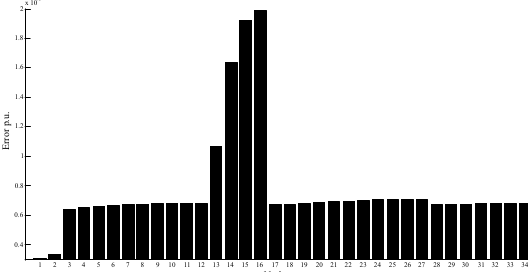
Fig. 2. Voltages error in p.u. for DS34N test system between backward-forward sweep algorithm and EVs-IPP mathematical model